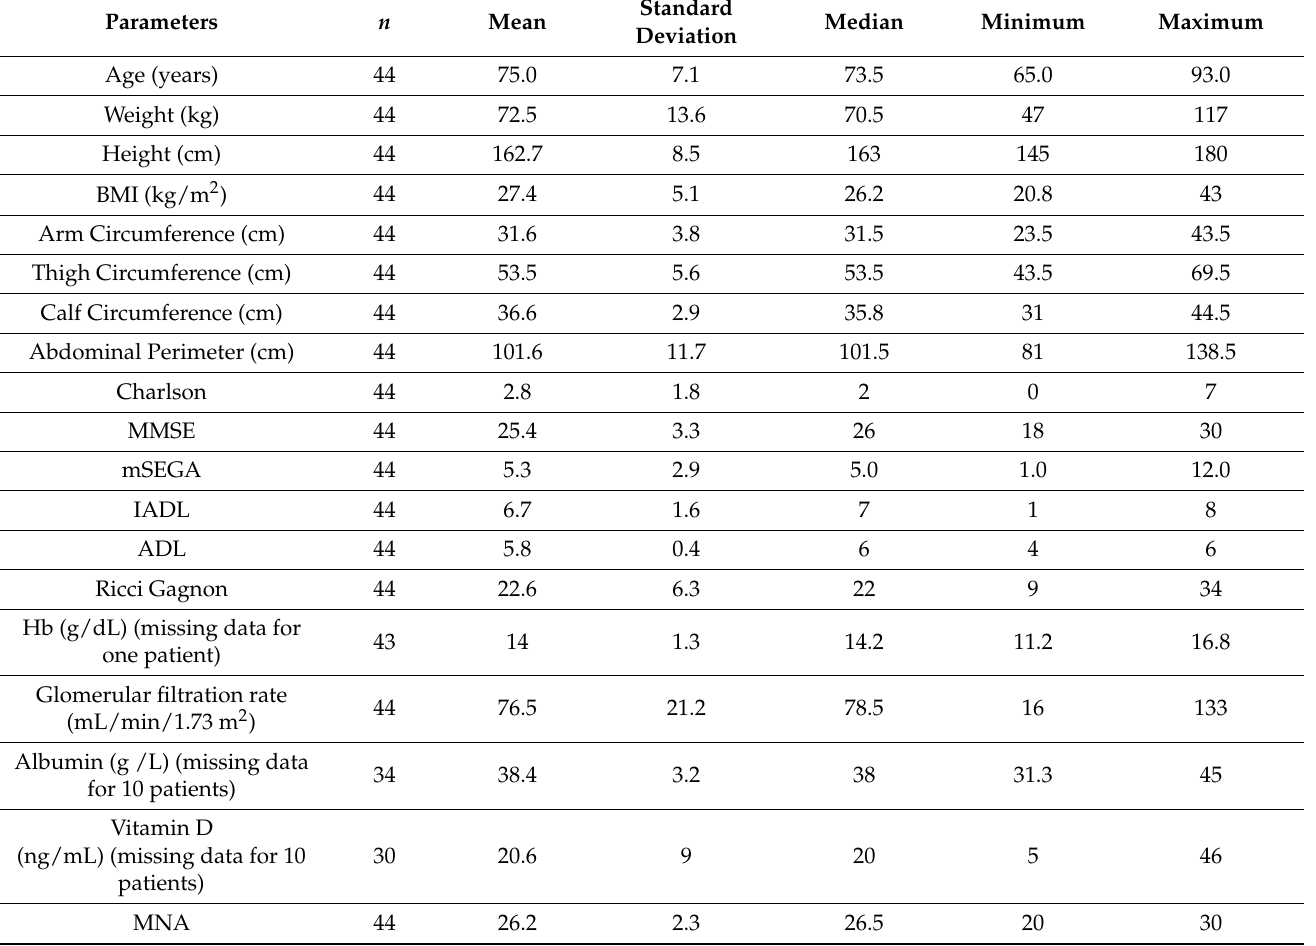
Table 2. Statistical analyses about nutritional, cognitive, frailty, biological and geriatric